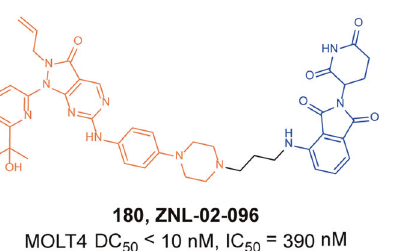
Fig. 47 The representative PROTACs targeting CDK12